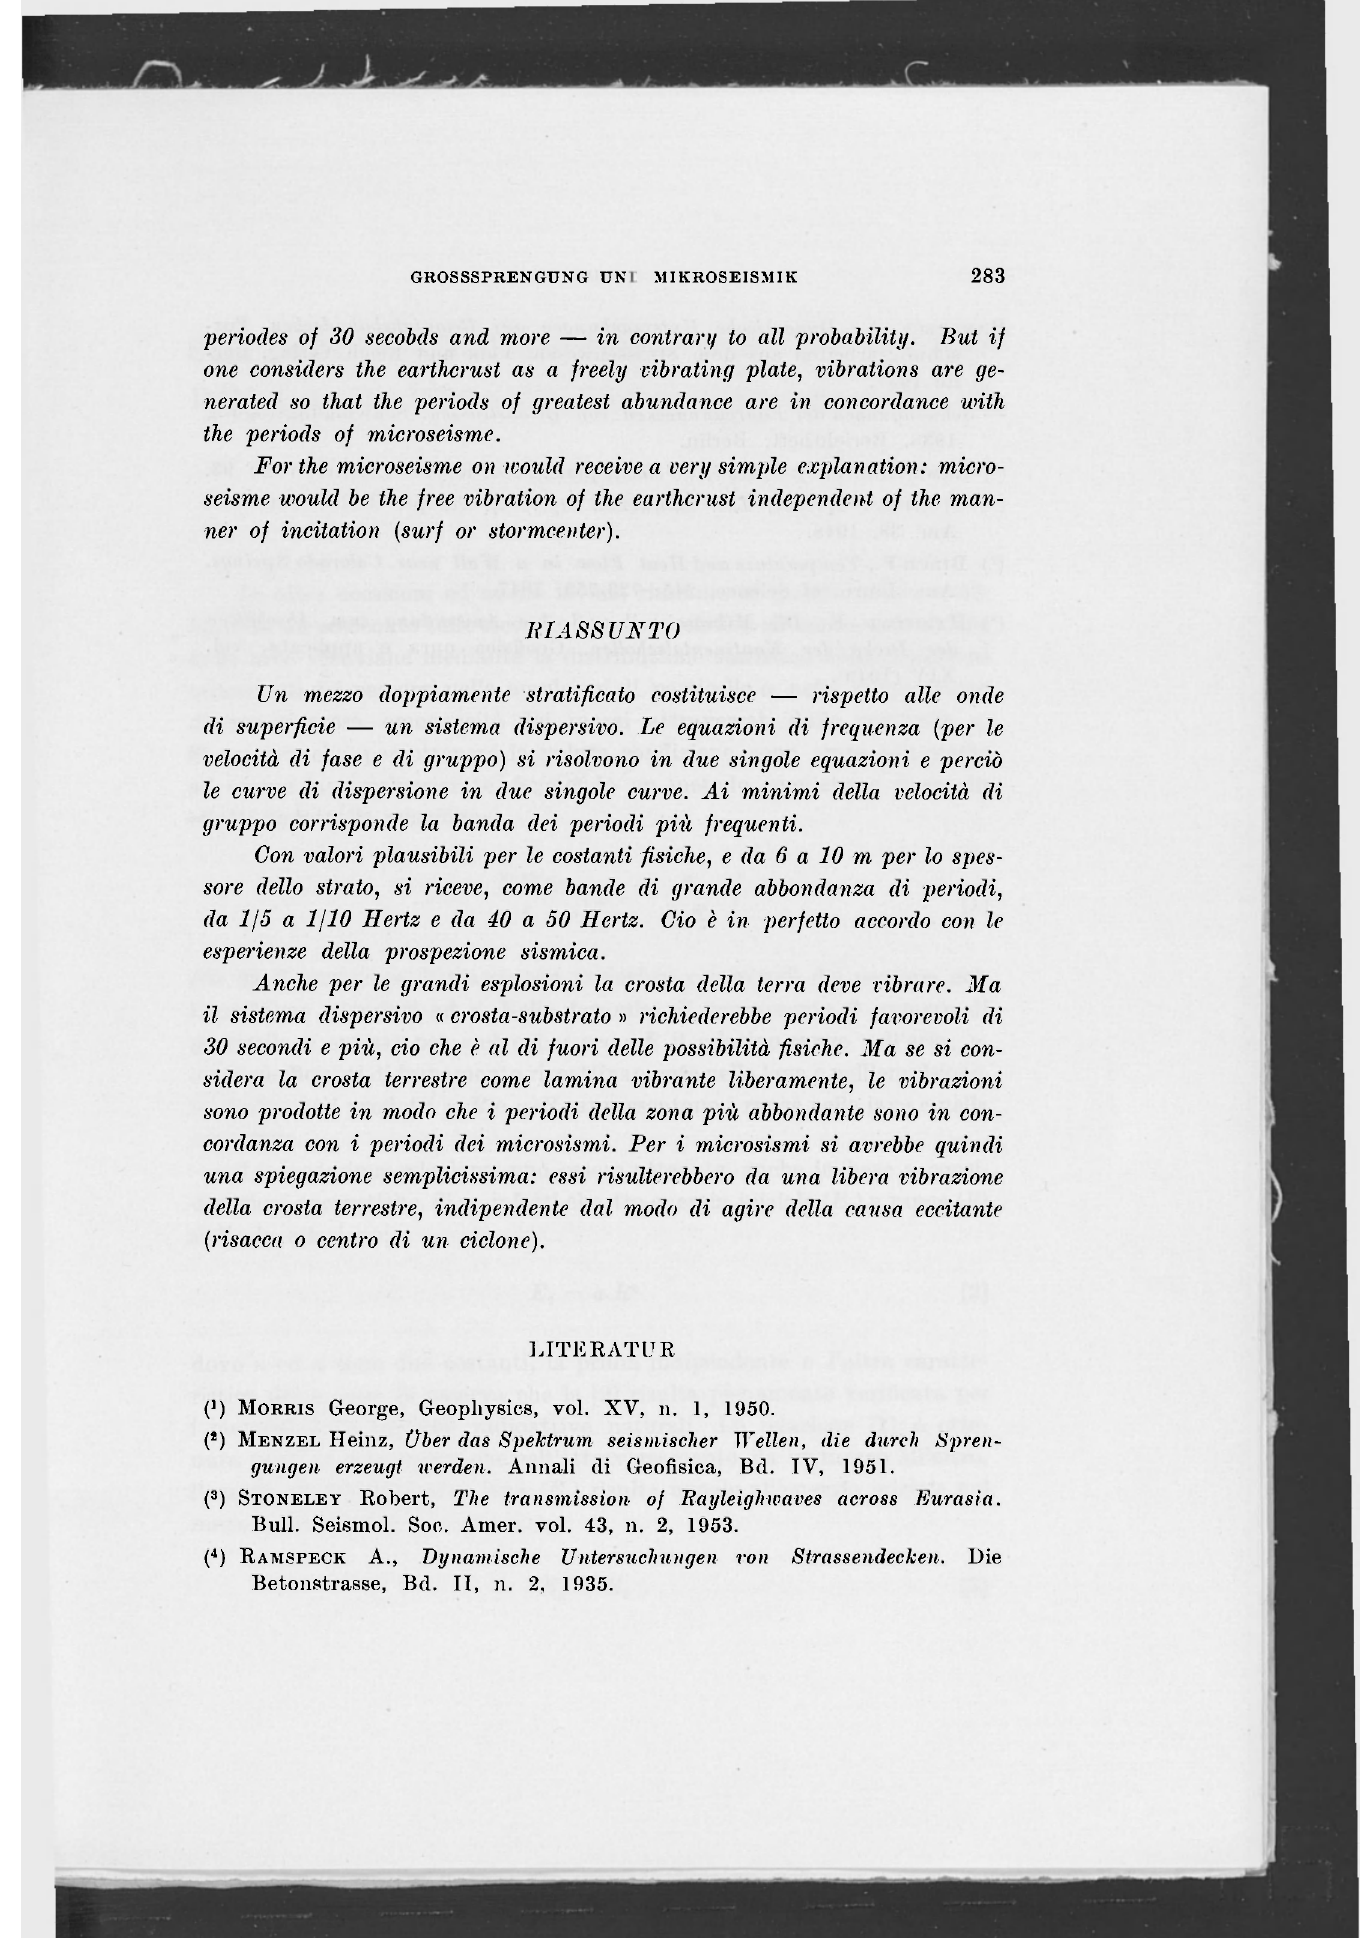
della crosta terrestre, indipendente dal modo di agire della causa eccitante (risacca o centro di un